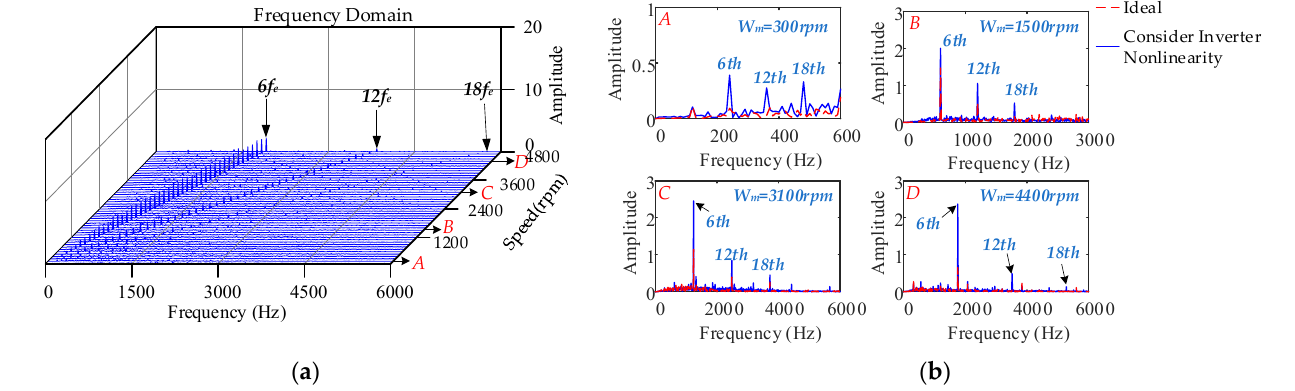
Figure 12. Frequency domain results of electromagnetic torque under different rotational speeds: ( a ) waterfall diagram of electromagnetic torque; ( b ) comparison results of electromagnetic torque. In the low-speed region, the amplitude of the torque ripple is small, indicating that the motor control system can effectively regulate the low-frequency torque ripple. The amplitude of the torque ripple is large in the middle- and high-speed regions; the 6th order torque ripple component is dominant, and the contributions of the 12th and 18th order torque ripple components are small. With an increase in speed, the amplitude of the 12th order torque fluctuation first increases and then decreases owing to the interaction between the voltage error caused by SVPWM and the harmonic current caused by the nonlinear characteristics of the inverter.